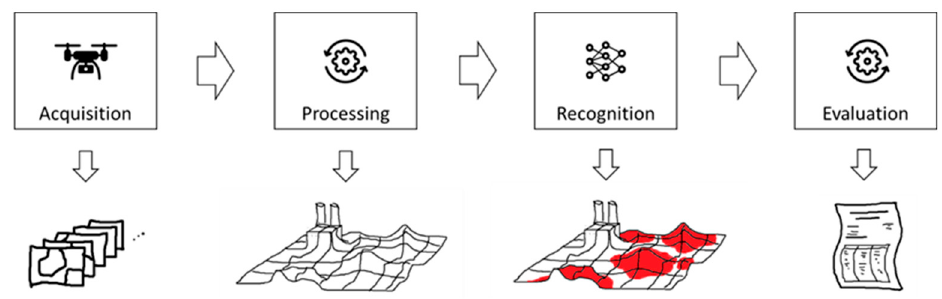
Figure 2. Context and industrial application of material heap